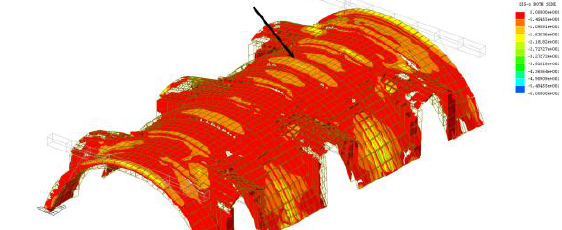
Figure 20a. Compression at the extrados before consolidation